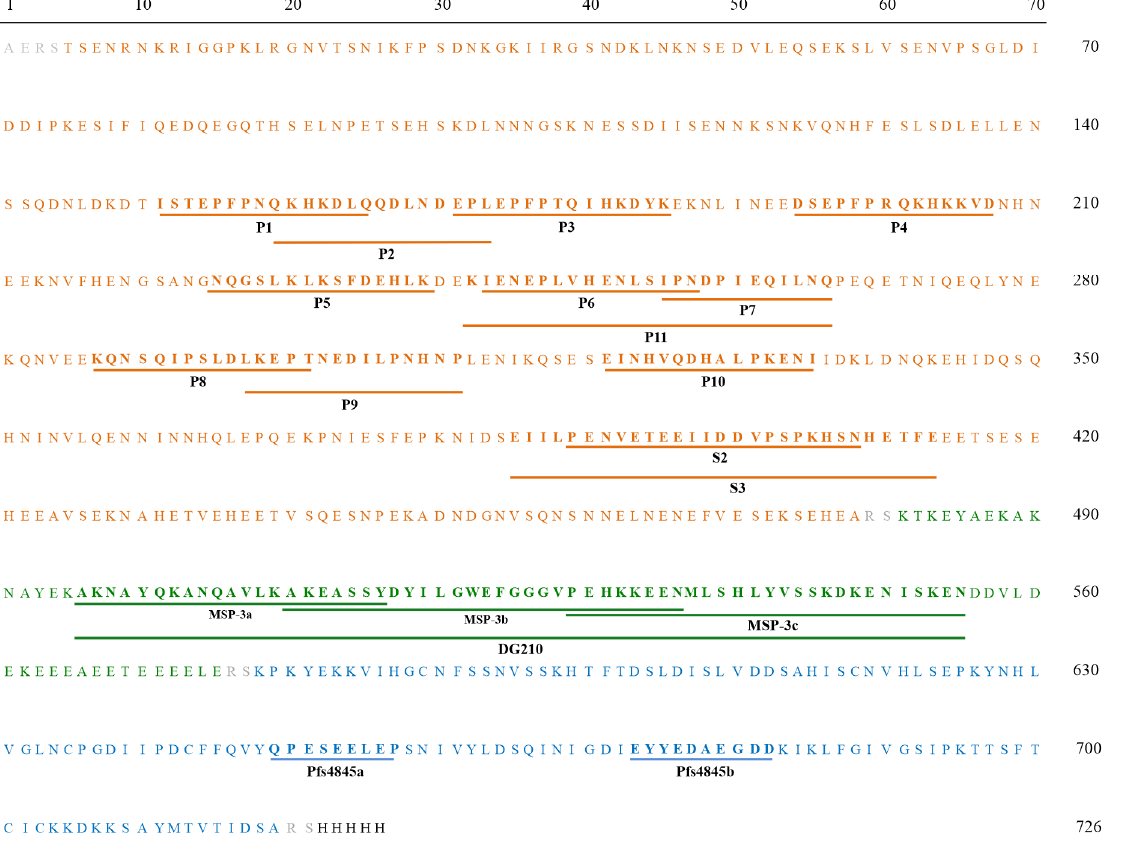
Figure 1. Amino acid sequence and linear epitopes of GMZ2.6c hybrid protein. Amino acid sequence of Pf GLURP (orange), Pf MSP-3 (green), and Pf s48/45 (blue). Bold letters represent linear epitopes. Orange, green, and blue lines represent Pf GLURP, Pf MSP-3, and Pf s48/45 epitopes, respectively.